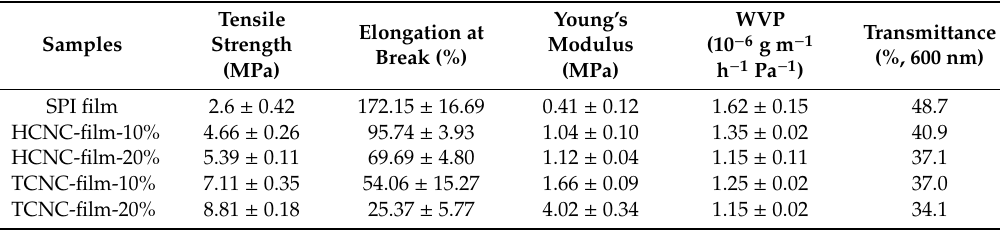
Table 1. Physical properties of soy protein isolate (SPI) and SPI / cellulose nanocrystal (CNC) films. WVP, water vapor